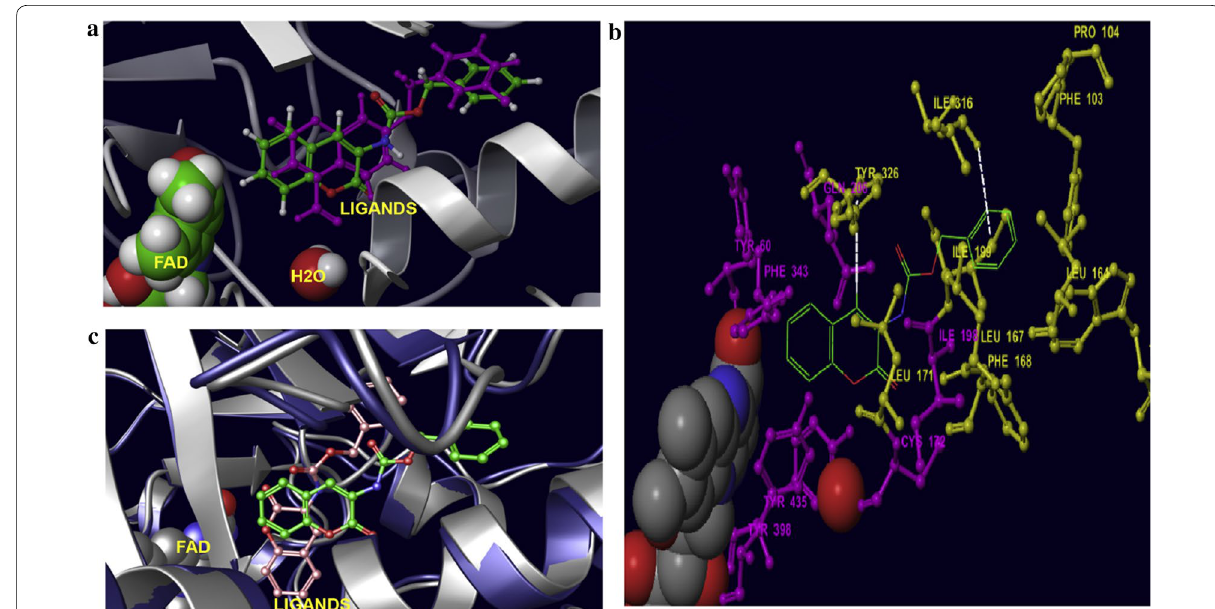
Fig. 68 Comparison of the co-crystallized ligand C84i (purple color) and the calculated pose for the compound C84h (colored by element, green carbons) by the docking simulation in the hMAO-B ( a , b , c ) [95]